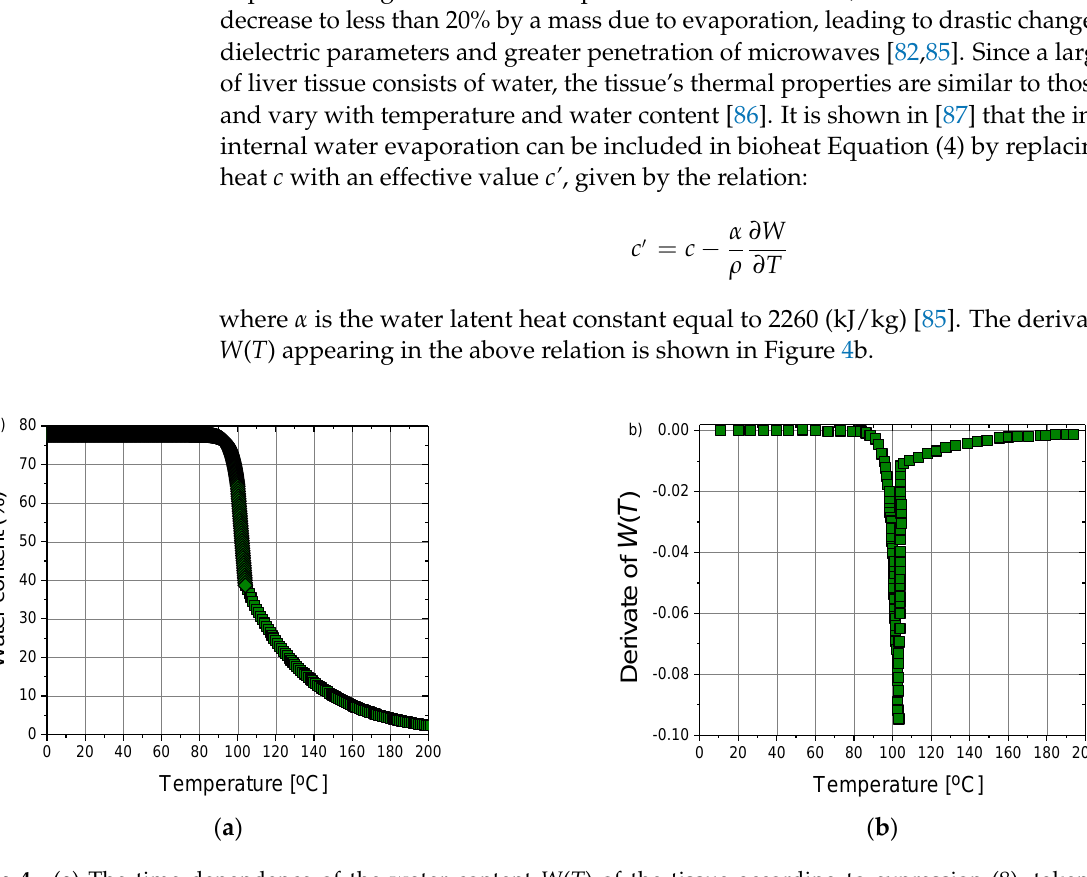
Figure 4. ( a ) The time dependence of the water content W ( T ) of the tissue according to expression (8), taken from reference [85] and ( b ) the first derivate of W ( T ) which is then used to calculate an effective specific heat given by Equation (9).